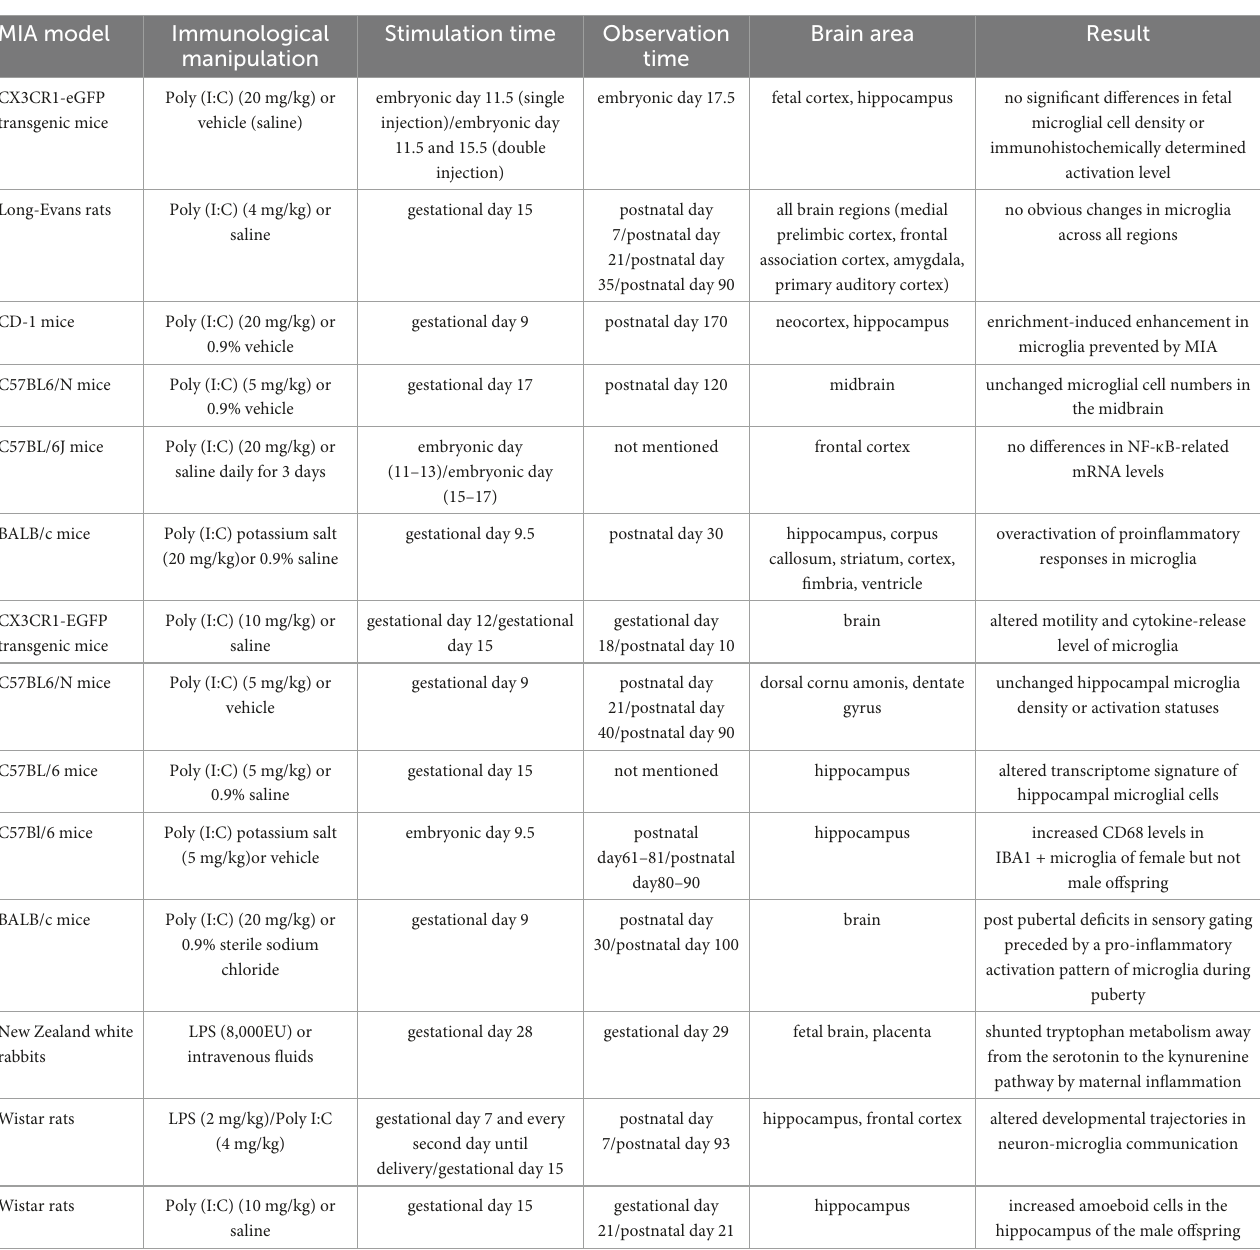
TABLE 2 Changes in microglia in the MIA